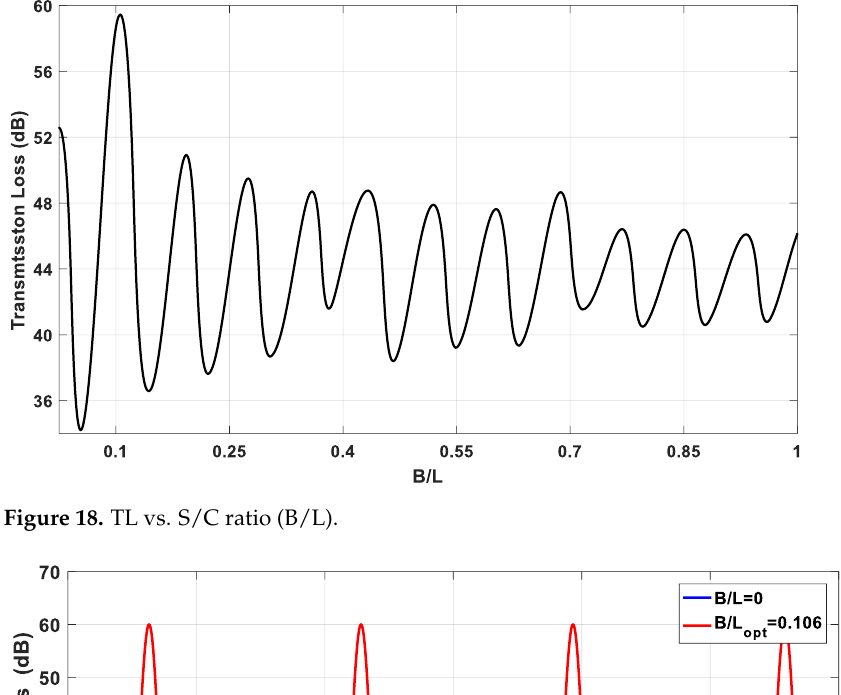
Figure 18. TL vs. S/C ratio (B/L).